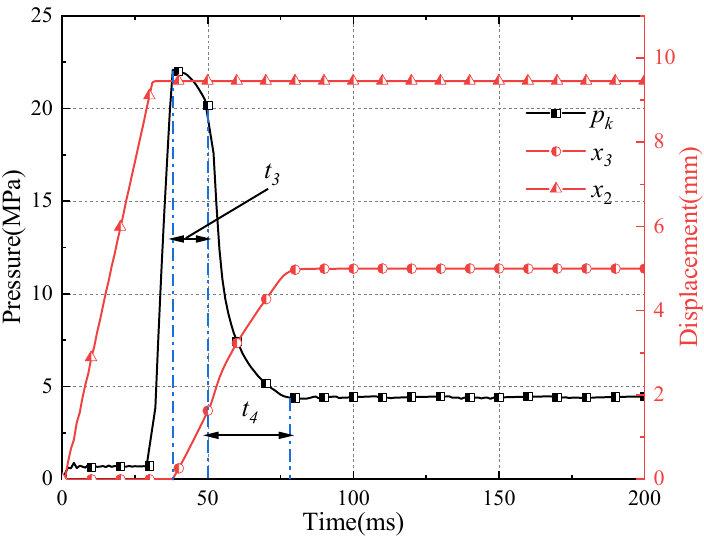
Figure 13. The pressure of the control chamber.